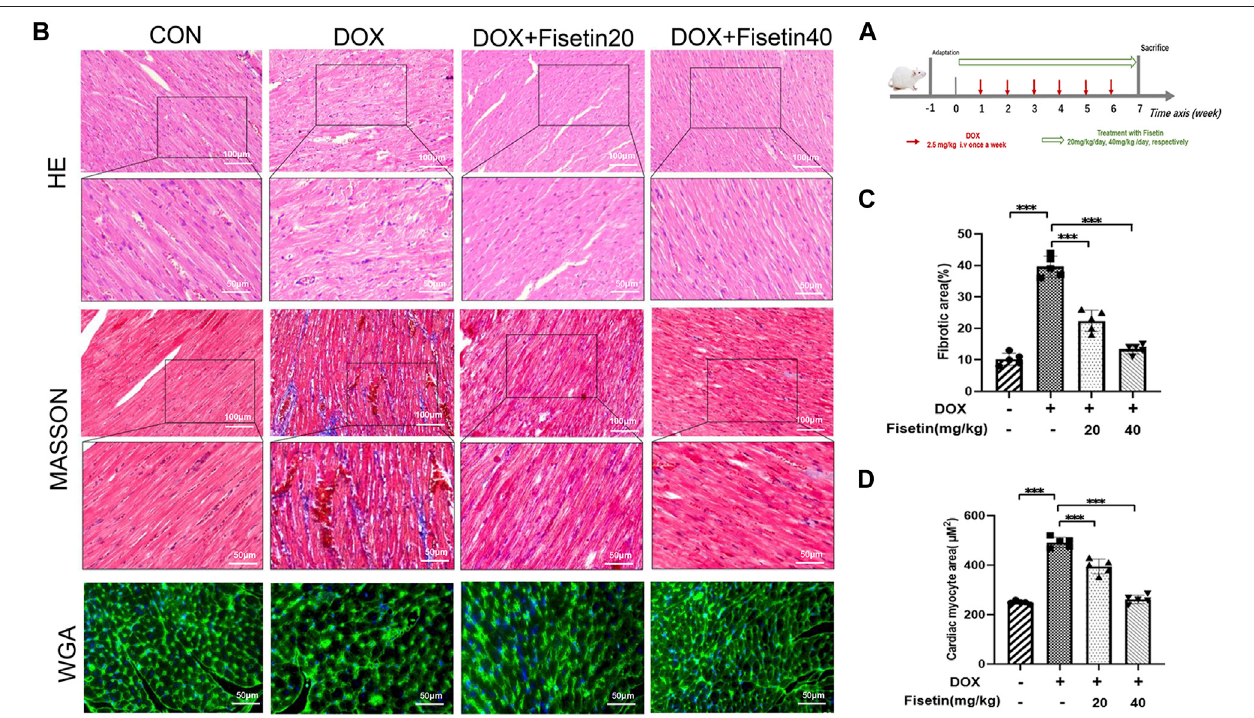
FIGURE 1| Fisetin exerts a protective effectin DOX-induced cardiac tissue damage in rats. (A) . Experimental design for evaluationof the protective effect of fi setin on DOX-induced cardiomyopathy in rats ( n = 6 per group). (B) . Representative images of H&E staining, Masson ’ s staining, and WGA staining for assessment of cardiac injury, myocardial fi brosis, and cardiac hypertrophy in rats after treatment of DOX and/or fi setin (200X and 400X, Scale bar = 100 and 50 μ m). (C) . Quanti fi cation of the fi brotic area from Masson ’ s staining sections and (D) Cardiomyocyte hypertrophy from WGA staining sections ( n = 5). The values are presented as mean ± SD. *** p < 0.001; DOX, doxorubicin; H&E, hematoxylin and eosin; WGA, wheatgerm agglutinin.